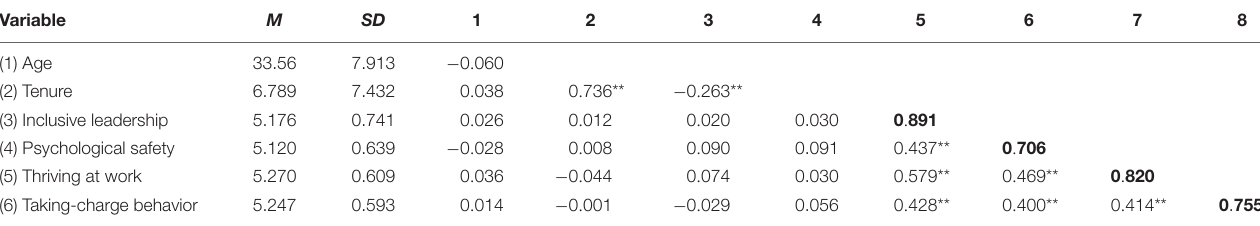
TABLE 1 | Means, standard deviation, correlations, and reliability estimates of the study variables. Variable